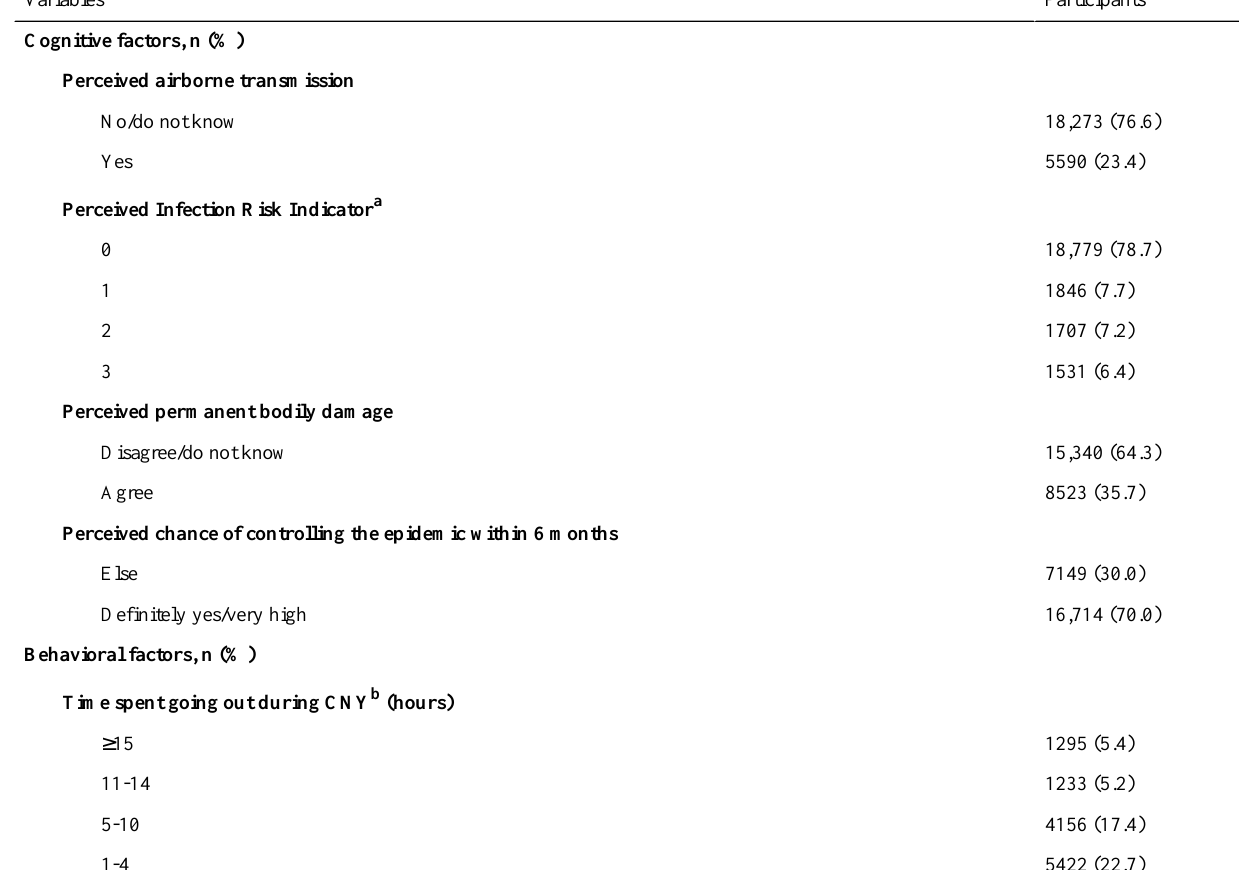
Table 2. Descriptive statistics of the independent variables, the mediator, and the dependent variable